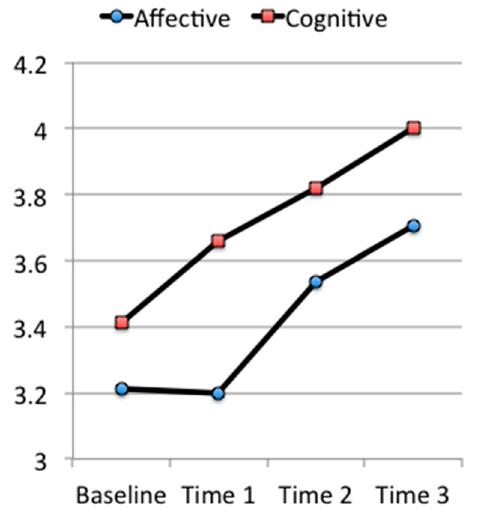
Figure 1. Latent growth curves for cognitive and affective trust.